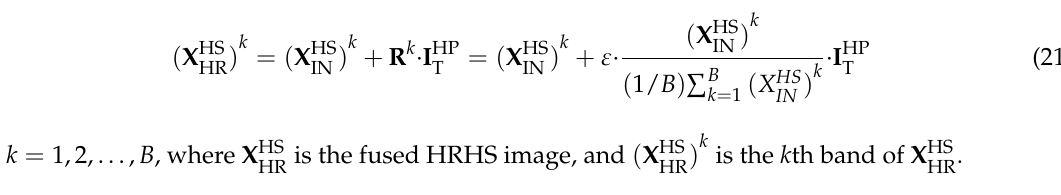
is also not unique.